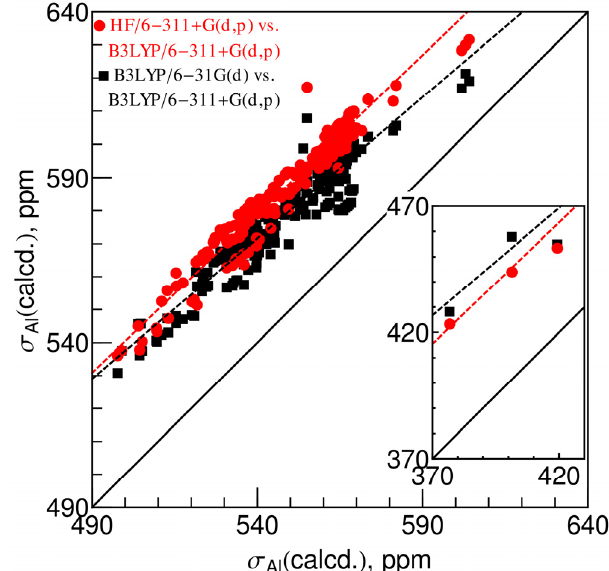
Figure 1. Correlation between the calculated isotropic 27 Al chemical shielding constants using the X-ray crystallographic geometries at the B3LYP/6-31G(d) (black squares) and the HF/6-311+G(d,p) (red circles) levels versus those obtained at the B3LYP/6-311+G(d,p) level. The black dashed line and the red dashed line are the best-fit linear regression of the two data sets, respectively, and the best-fit equations are given in Equations 1 and 2. The solid black line is the ideal diagonal line ( y = x